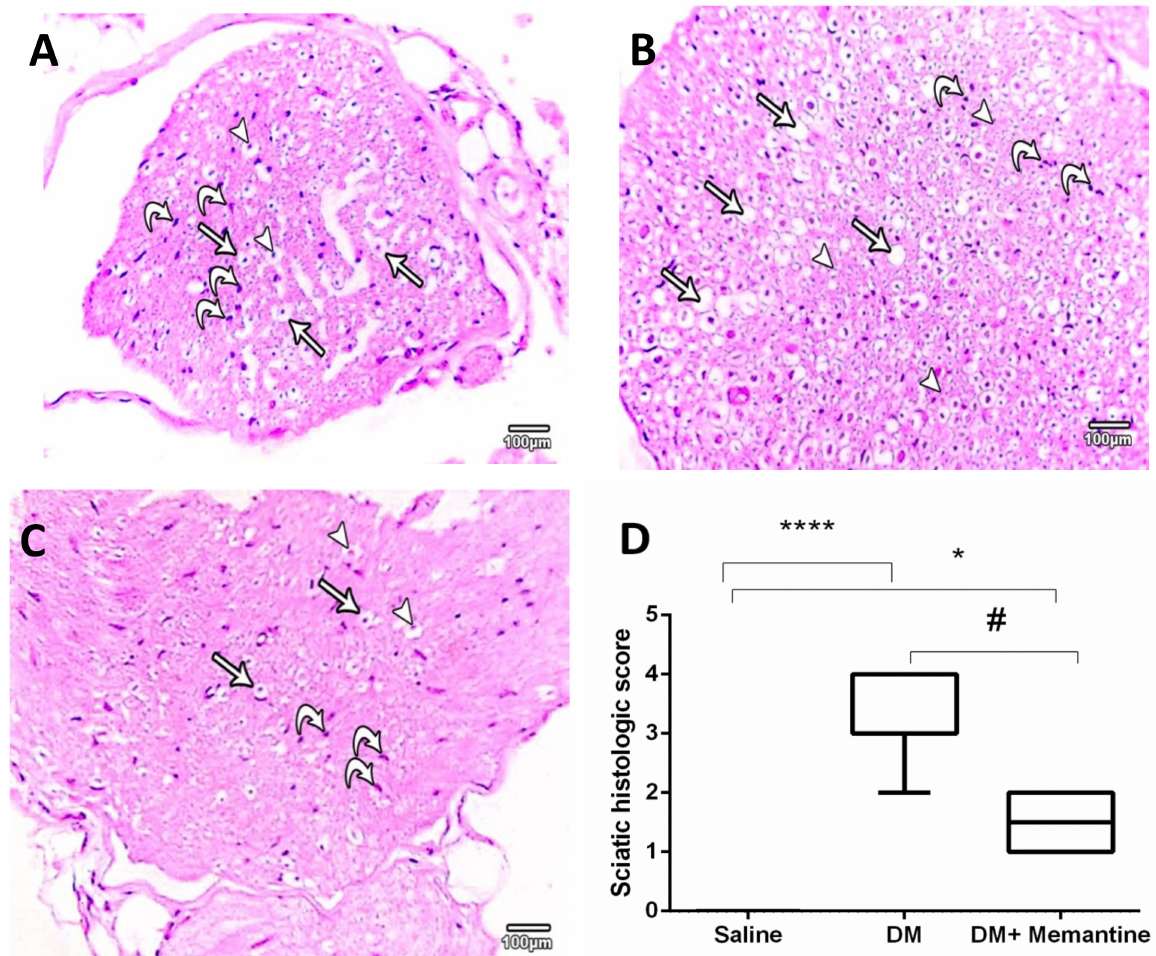
Figure 5. Microscopic pictures of hematoxylin and eosin stained sections of sciatic nerves. ( A ) An image from the saline group presenting multiple axons (arrowheads) found in different thicknesses of myelin sheathes (arrows) and enclosed within the endoneurium with multiple nuclei of Schwann cells (curved arrows). ( B ) Diabetic group (DM) showing several lost axons (arrows) with lost myelin sheathes (arrowheads) with some Schwann cell nuclei (curved arrows). ( C ) DM+memantine shows normal neuronal axons (arrowheads) with normal myelin sheath (arrows) and an increased number of Schwann cells nuclei (curved arrows). × 100 bar 100 µ m. ( D ) Data from histopathologic scoring of the sciatic nerve sections as a box-whisker plot demonstrating the median values and analyzed by Kruskal–Wallis ANOVA. * p < 0.05, and **** p < 0.0001, versus the saline group; # p < 0.05 versus the DM